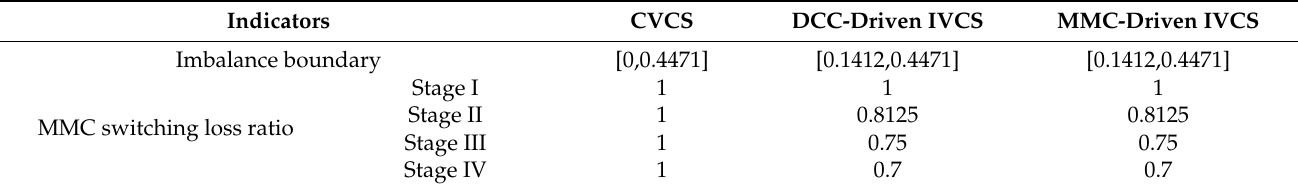
Table 6. The indicator improvement of MMC-driven